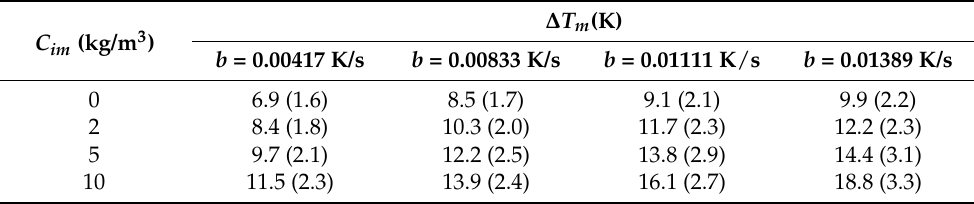
Table 3. The average MSZWs, ∆ T m , in the MSZW measurements for a solution saturated at T 0 = 318 K cooled at various impurity concentrations, C im , and cooling rates. The standard deviations in the least significant digits are given in